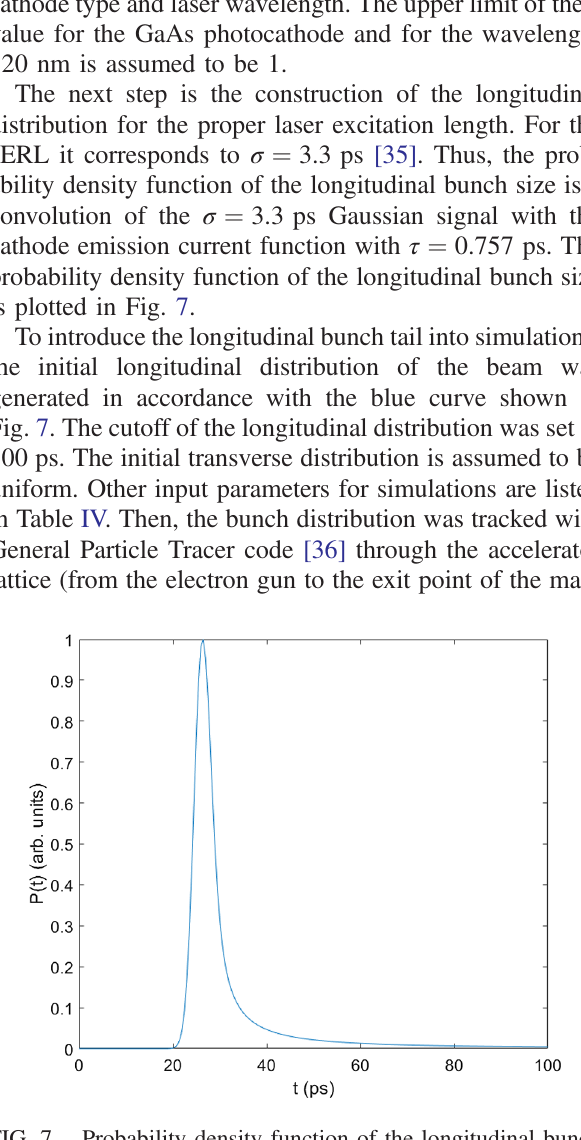
FIG. 7. Probability density function of the longitudinal bunch size obtained via convolution of the σ ¼ 3 . 3 ps Gaussian signal with the cathode emission current function with τ ¼ 0 . 757